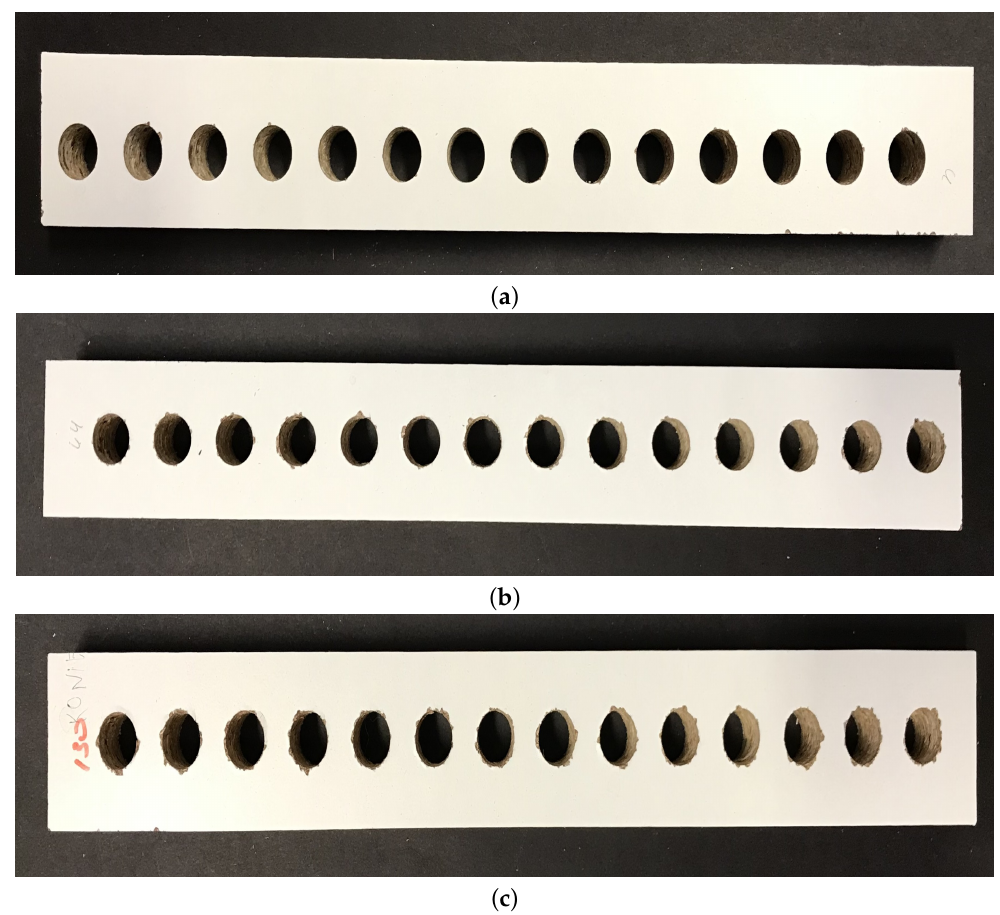
Figure 2. Example initial profile scans with drilled holes representing three recognized wear classes: Good ( a ), Worn ( b ) and Requiring replacement ( c